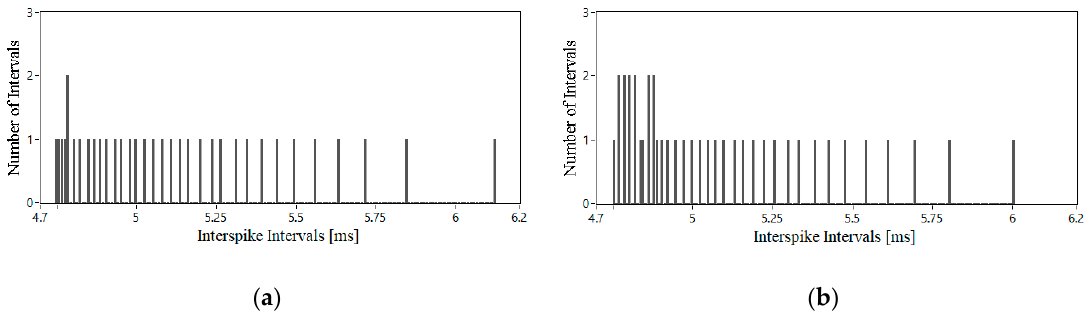
Figure 10. Interspike intervals for dynamical system (1) when applying a triangular input signal of period T = 800 ms and amplitude I = 40 µA for DBL ( a ) and 32-bit FXP ( b ) Euler method solvers.